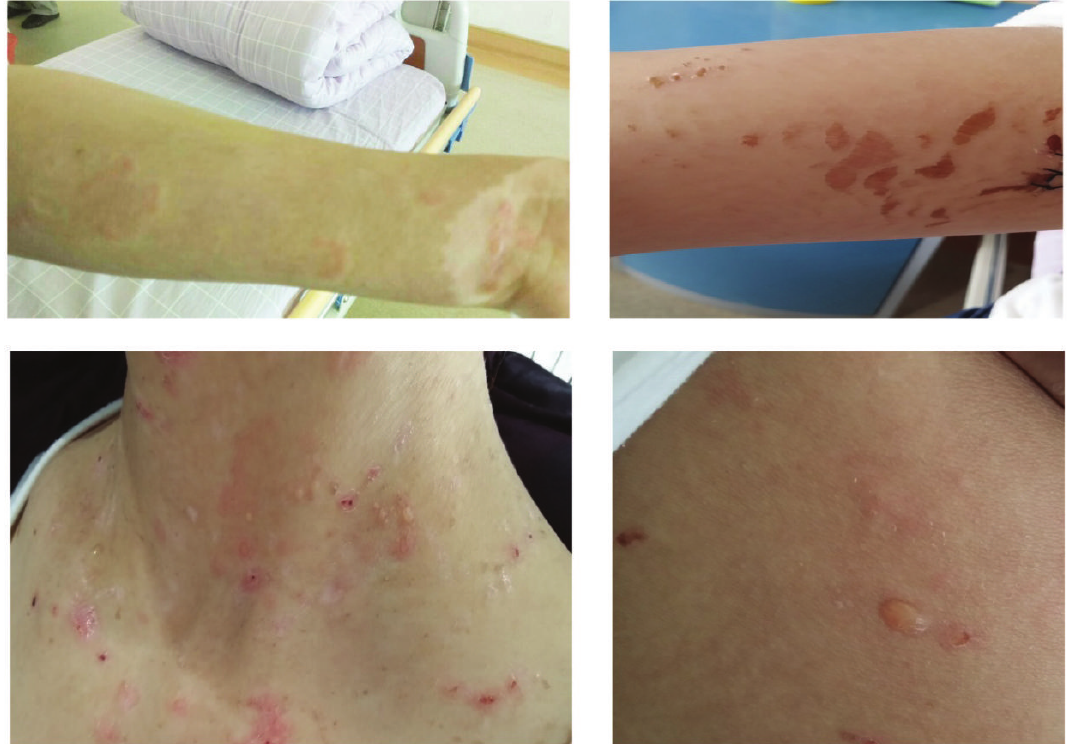
Figure 1: Gross view of the skin lesion. Presence of tense vesicles (marked with an arrow) filled with clear fluid on the arm, neck, and